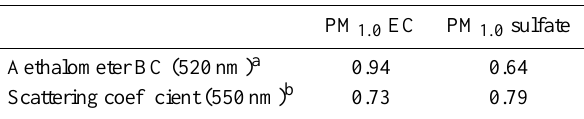
Table 3. Correlation coefficients of absorption and scattering prop- erties of aerosols with EC and sulfate concentrations in PM 1 . 0